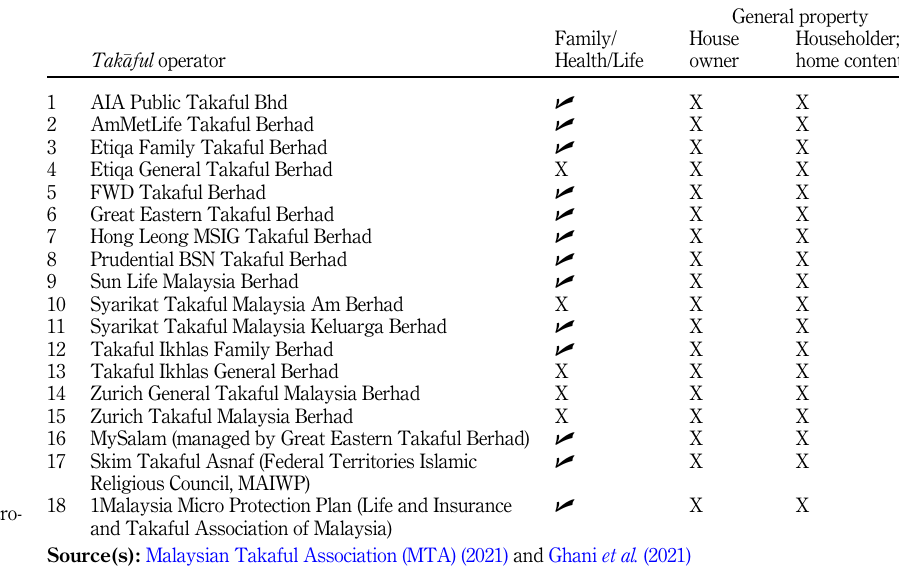
and home contents in Malaysia